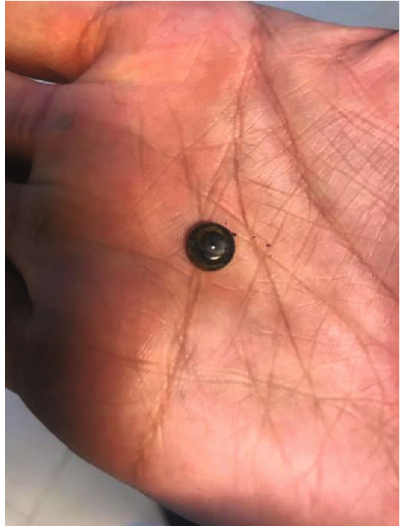
Figure 2: Removed alkaline button battery from left inferior fornix in a child.